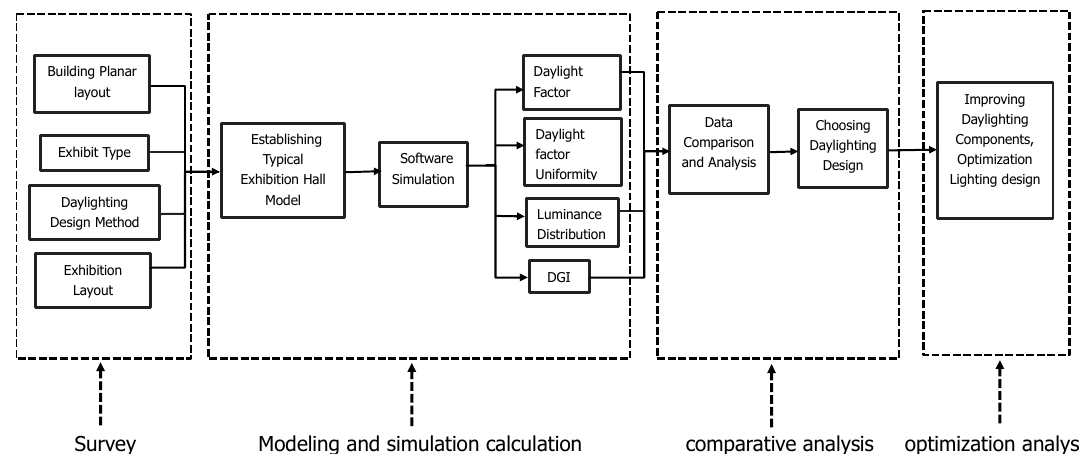
Figure 6. Simulation procedures of daylighting design of exhibition space.